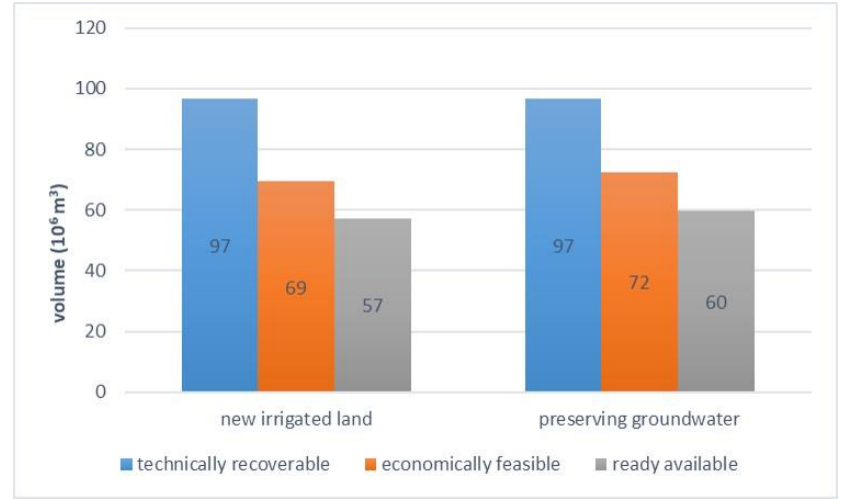
Figure 3. Technically recoverable, economically feasible and readily available reclaimed wastewater